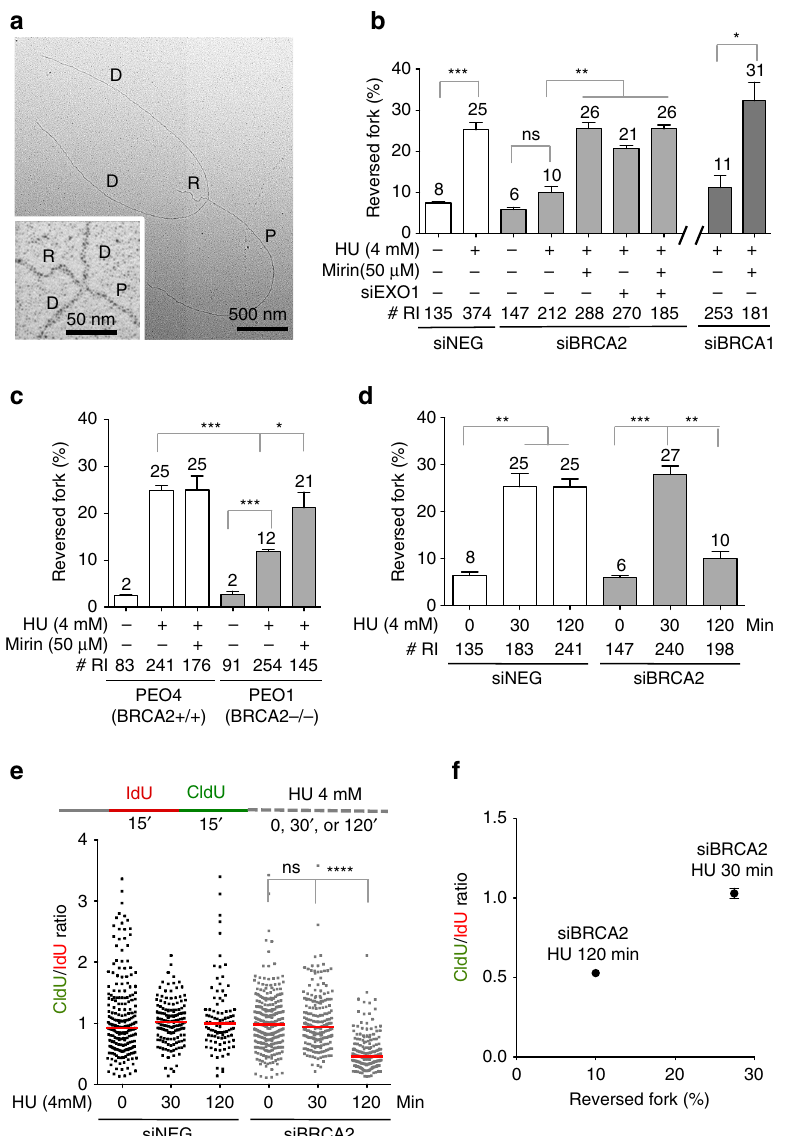
Fig. 2 BRCA1 and BRCA2 protect reversed replication forks from MRE11- and EXO1-dependent degradation following HU treatment. a Representative electron micrograph of a reversed fork observed on genomic DNA upon HU treatment. Inset, magni fi ed four-way junction at the reversed replication fork. D daugher strand, P parental strand, R reversed arm. b Frequency of fork reversal in BRCA1- and BRCA2-de fi cient U2OS cells treated with 4 mM HU for 5 h. Cells were transfected with control siRNA (siNEG) or EXO1 siRNA. Mirin (50 μ M) was added concomitantly with HU, as indicated. The percentage values are indicated on the top of the bar. “ # RI ” indicates the number of analyzed replication intermediates. Mean shown, n = 3. Errors, S.E.M. Statistics: unpaired t test; * P < 0.05; ** P < 0.01; *** P < 0.001. c Frequency of fork reversal in BRCA2-pro fi cient PEO4 and BRCA2-de fi cient PEO1 cells treated with 4 mM HU for 5 h. Mirin (50 μ M) was added concomitantly with HU, as indicated. The percentage values are indicated on the top of the bar. “ # RI ” indicates the number of analyzed replication intermediates. Mean shown, n = 3. Errors, S.E.M. Statistics: unpaired t test; * P < 0.05; *** P < 0.001. d Frequency of fork reversal in BRCA2-de fi cient U2OS cells treated with 4 mM HU for 0, 30, or 120 min. The percentage values are indicated on the top of the bar. “ # RI ” indicates the number of analyzed replication intermediates. Mean shown, n = 3. Errors, S.E.M. Statistics: unpaired t test; ** P < 0.01; *** P < 0.001. e CldU/IdU tract ratio in BRCA2-de fi cient U2OS cells treated with 4 mM HU for 0, 30, or 120 min. Out of 3 repeats; n ≥ 250 tracts scored for each data set. Bars represent the median. Statistics: Mann – Whitney; **** P < 0.0001. f Plot the percentages of reversed forks as a function of mean values of the CldU/IdU ratios measured after treating BRCA2-de fi cient U2OS cells with 4 mM HU for 30 or 120 min. Errors,